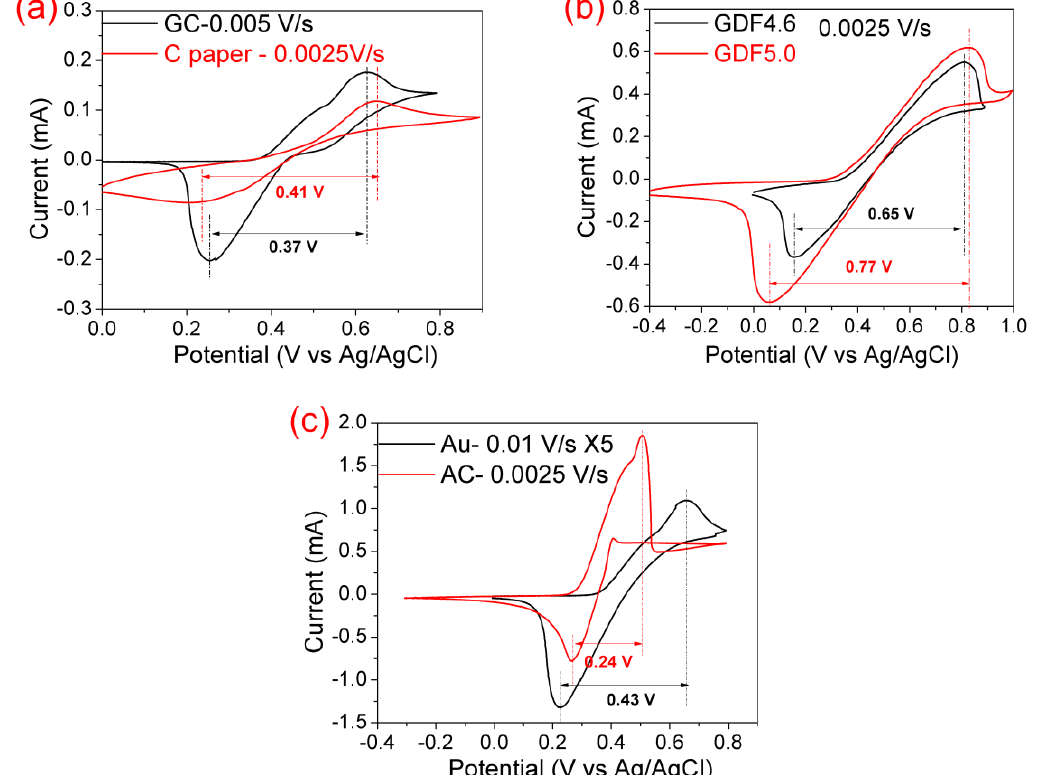
Figure 2. Cyclic voltammograms of 0.01 M I 2 –1.5 M NaI catholyte on ( a ) Au and ( b ) Pt. Ag/AgCl and Pt wire were used as reference and counter electrodes, respectively. The scan rates are indicated in each figure.